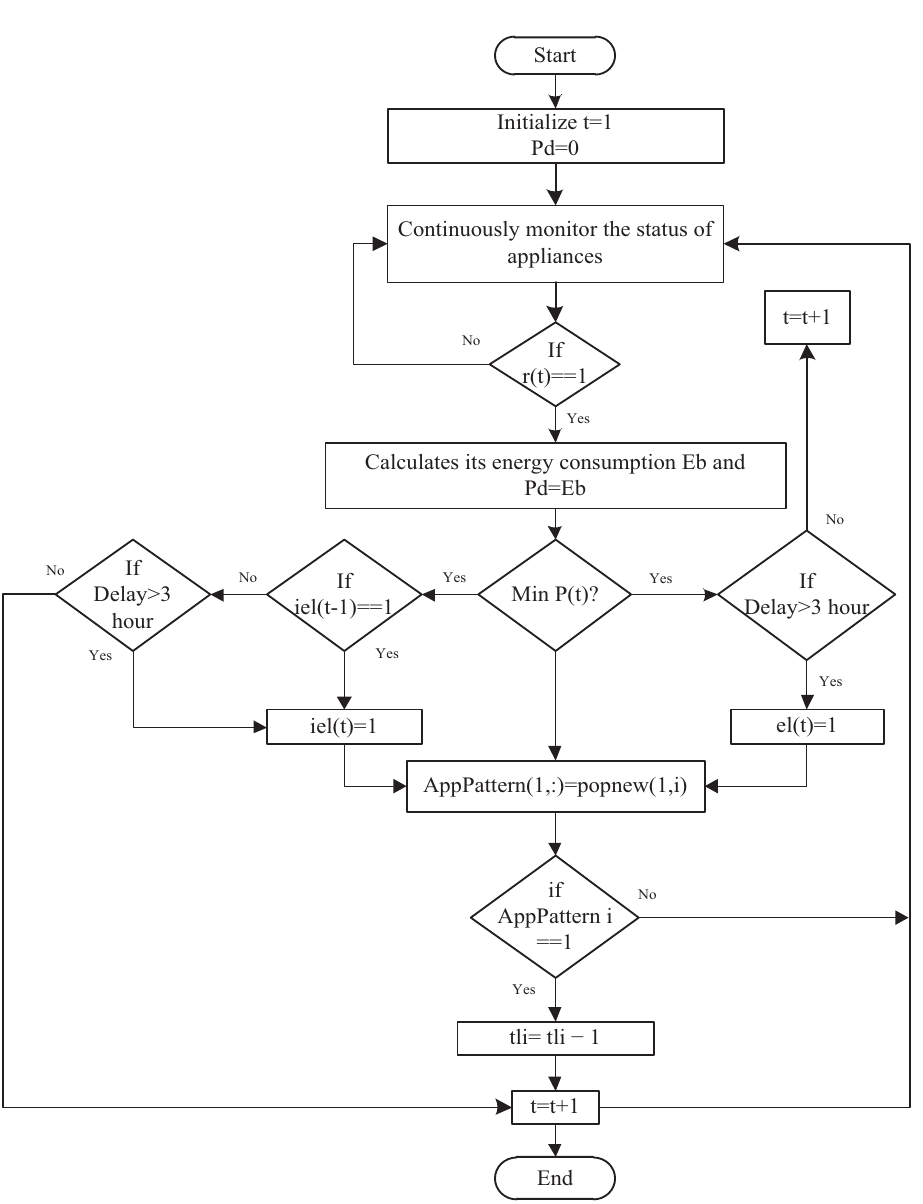
Figure 19. Energy management algorithm of r , el and iel